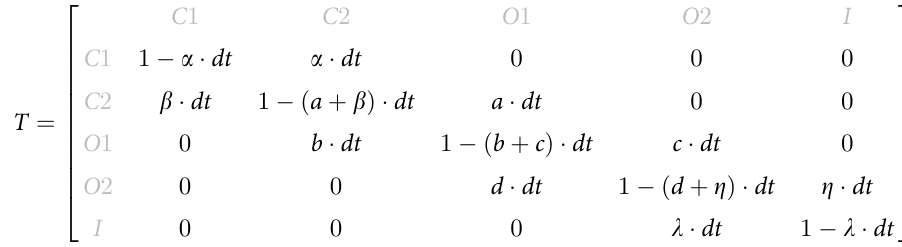
S1 Table. Parameters of hidden Markov models used in the A549 whole-cell current model. Rate constants for transitions between the states of all hidden Markov models. For cal- cium dependent transitions the calculated steady state calcium concentration Ca_i = 4.68 μ M